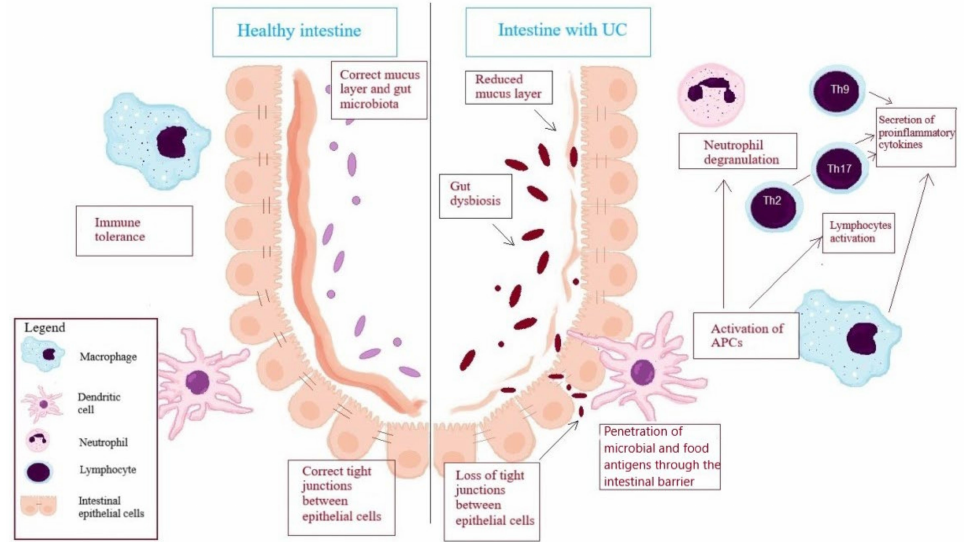
Figure 1. Pathogenesis of ulcerative colitis (UC). APCs—antigen presenting cells; In physiological conditions, a homeostasis between natural microbiota and immune system is maintained. Intestinal mucosa is covered by a thick layer of mucus preventing the penetration of intestinal bacteria to epithelial cells. Integrity of the intestinal barrier is provided by the tight junctions between epithelial cells, and the immune cells present a state of immune tolerance. In UC, a layer of mucus is reduced and the gut microbiota is abnormal, which leads to gut dysbiosis. A reduction of butyrate-producing bacteria (as a result of, e.g., antibiotic treatment) contributes to a decreased amount of butyrate in the intestinal lumen and enhances anaerobic metabolic processes, which generate less energy than the aerobic ones. The resulting oxidative stress damages the mucus-secreting colonocytes. Additionally, enhanced anaerobic processes favor the expansion of facultative anaerobes such as Salmonella enterica and Escherichia coli . Increased relative abundance of these bacterial species releasing bacterial enterotoxins directly attack and damage the intestinal epithelial cells, which in turn damages the intestinal mucosa and reduces its protective functions. The loss of tight junctions seen in UC allows bacteria and dietary antigens to pass through the intestinal barrier and leads to the activation of antigen-presenting cells. Macrophages and dendritic cells enhance neutrophil migration and degranulation, as well as activating lymphocytes Th2, Th17, Th9. Activation of immune cells results in the secretion of pro-inflammatory cytokines, i.e., TNF- α , IFN- γ , and IL-13, which increases